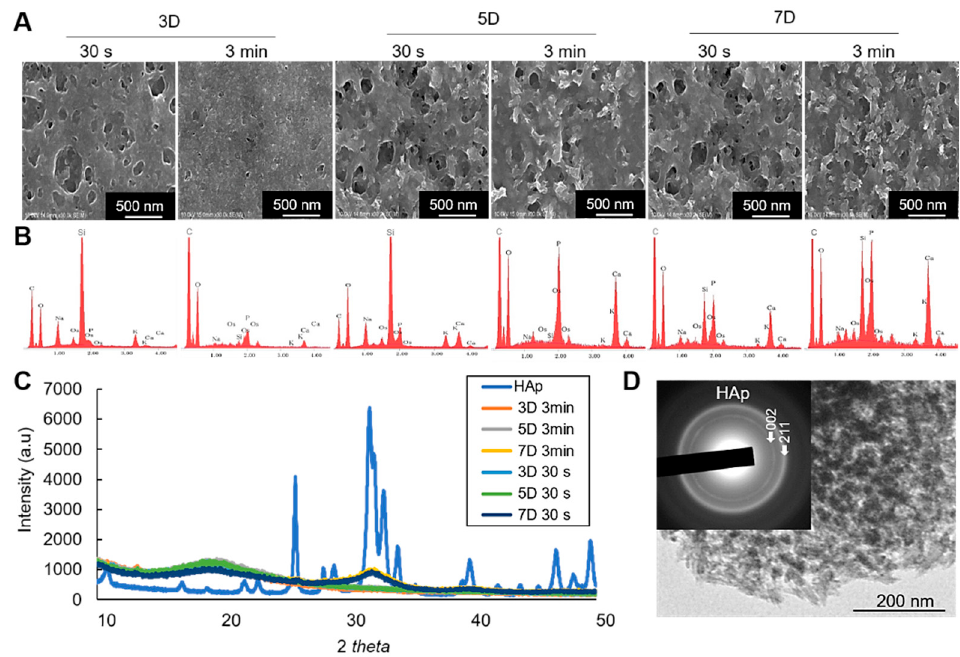
Figure 6. ( A ) SEM images of the mineralized cell nanofragments without NaClO treatment. ( B ) EDX analysis showing the incubation period-dependent increase in calcium and phosphate levels. Note that the amount of calcium in the nanofragments obtained by ultrasonication 3 min was higher compared to ultrasonication 30 s, at all time points; 3D: 3 days, 5D: 5 days, 7D: 7 days. ( C ) XRD analysis of the precipitated products (minerals), which were identified to be amorphous calcium phosphate (3D and 5D samples) or hydroxyapatite (7D samples) in the cell nanofragments obtained by either 30 s or 3 min. Commercially available hydroxyapatite (HAp) was used as a reference control. ( D ) TEM image and electron di ff raction analysis of the minerals formed from the cell nanofragments after 7 days of incubation. The cell nanofragments were collected from ATDC5 cells and incubated in α -MEM supplemented with 10 mM β -GP for up to 7 days.